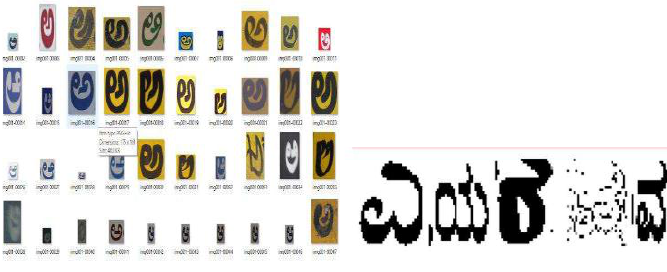
Fig. 10. Model building.